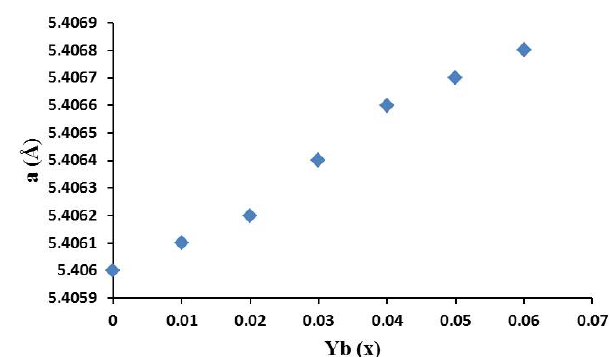
Fig. 2. The lattice constant of Yb Figure 2. The lattice constant of Yb x Zn 1-x S(x = 0 to 0.06) dependent upon Yb 3+ doping on Zn 2+